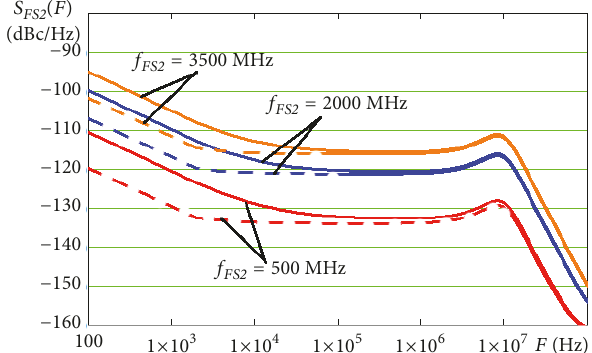
Figure10:SPDofthephasenoisesofahybridfrequencysynthesizer with a DDS as a referenceoscillator of the PLL and ACPDfor output frequencies of 500 MHz ( n = 3, N = 5, 𝐾 DDS = 0,333, and 𝑛 AA = 1,95), 2000 MHz ( n = 3, N = 20, 𝐾 DDS = 0,333, and 𝑛 AA = 1,95), and 3500 MHz ( n = 3, N = 35, 𝐾 DDS = 0,333, and 𝑛 AA = 1,95).